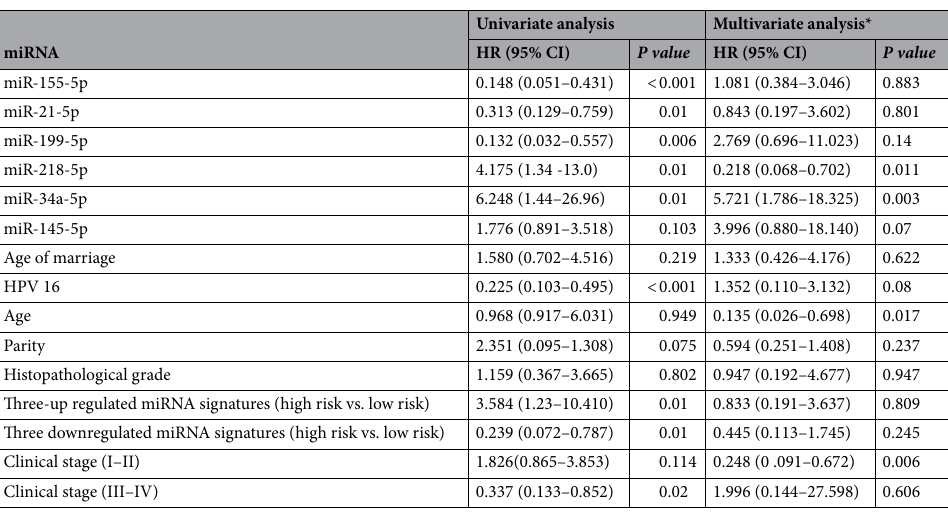
Table 4. Univariate and multivariate Cox regression analysis to evaluate the prognostic value of individual miRNAs. HR hazard ratio, CI Confidence interval. *Adjusted with age at diagnosis, age of marriage, parity, HPV infection, and tumor stage and grade.